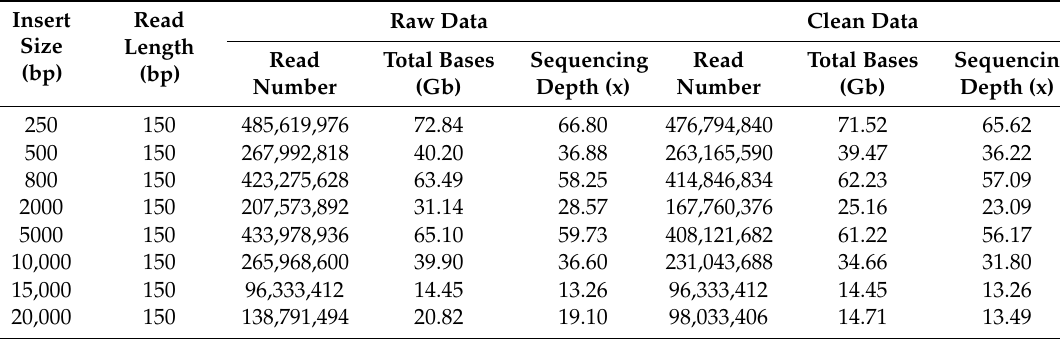
Table 1. Genome sequencing information of the Sichuan partridge.